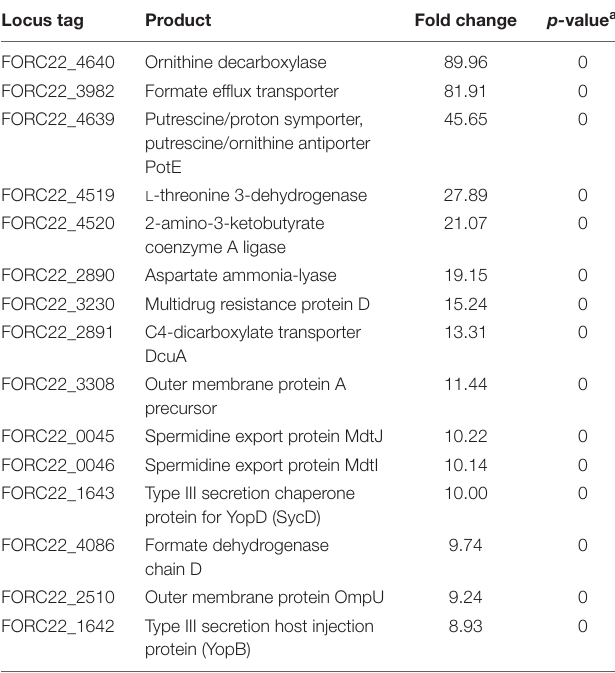
TABLE 3 | Top 15 up-regulated genes in the FORC_022 strain after exposure to